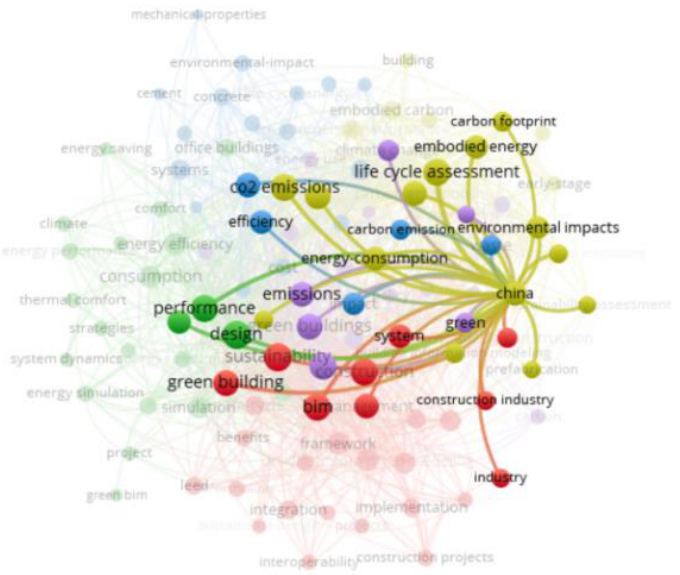
Figure 6. Network-visualization map with the theme of China (further highlighted in detail in Figure 4) in the WoS-core-collection database via VOSviewer software (generated by the authors).